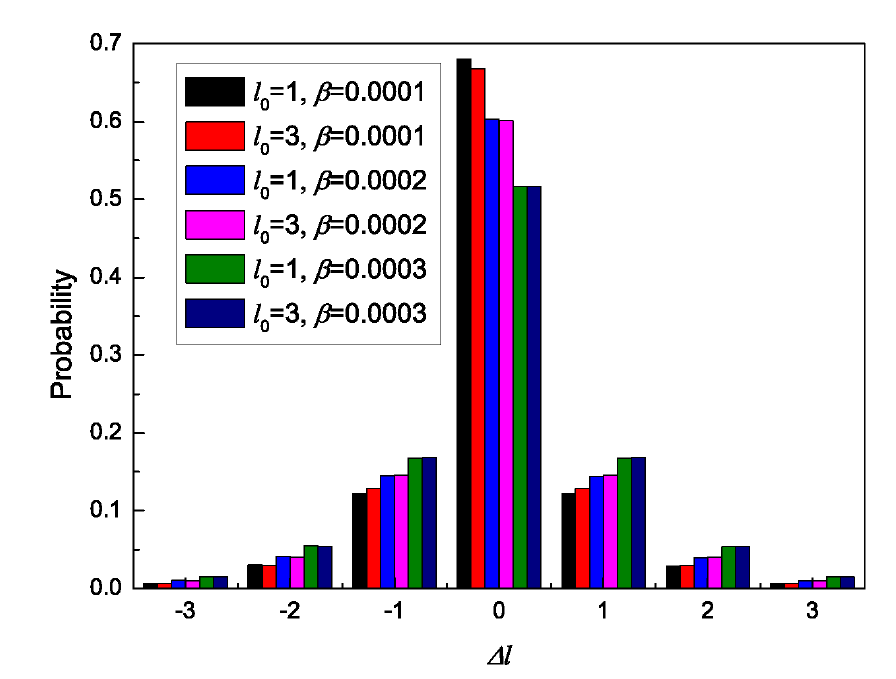
Figure 2. The normalized energy for each received vortex modes carried by Mathieu-Gaussian beam propagating in oceanic turbulence for different values of vortex topological charge 2 l 0 and semi-cone angle β ( ∆ l = l − 2 l 0 ).